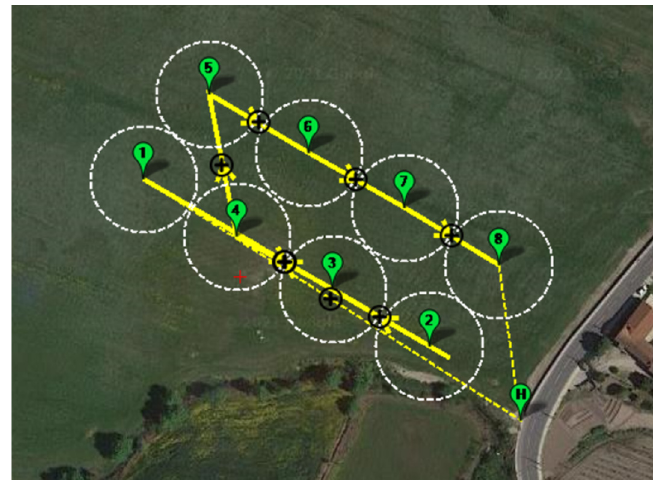
Figure 10. PoIs of the Case Study #3.